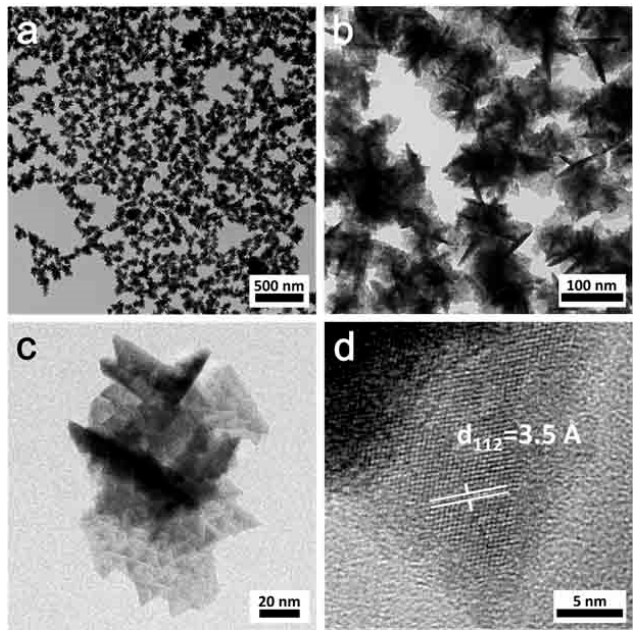
Figure 4. TEM ( a – c ) and HRTEM ( d ) of CuInTe 2 nanocrystals (4 mmol stearic acid).